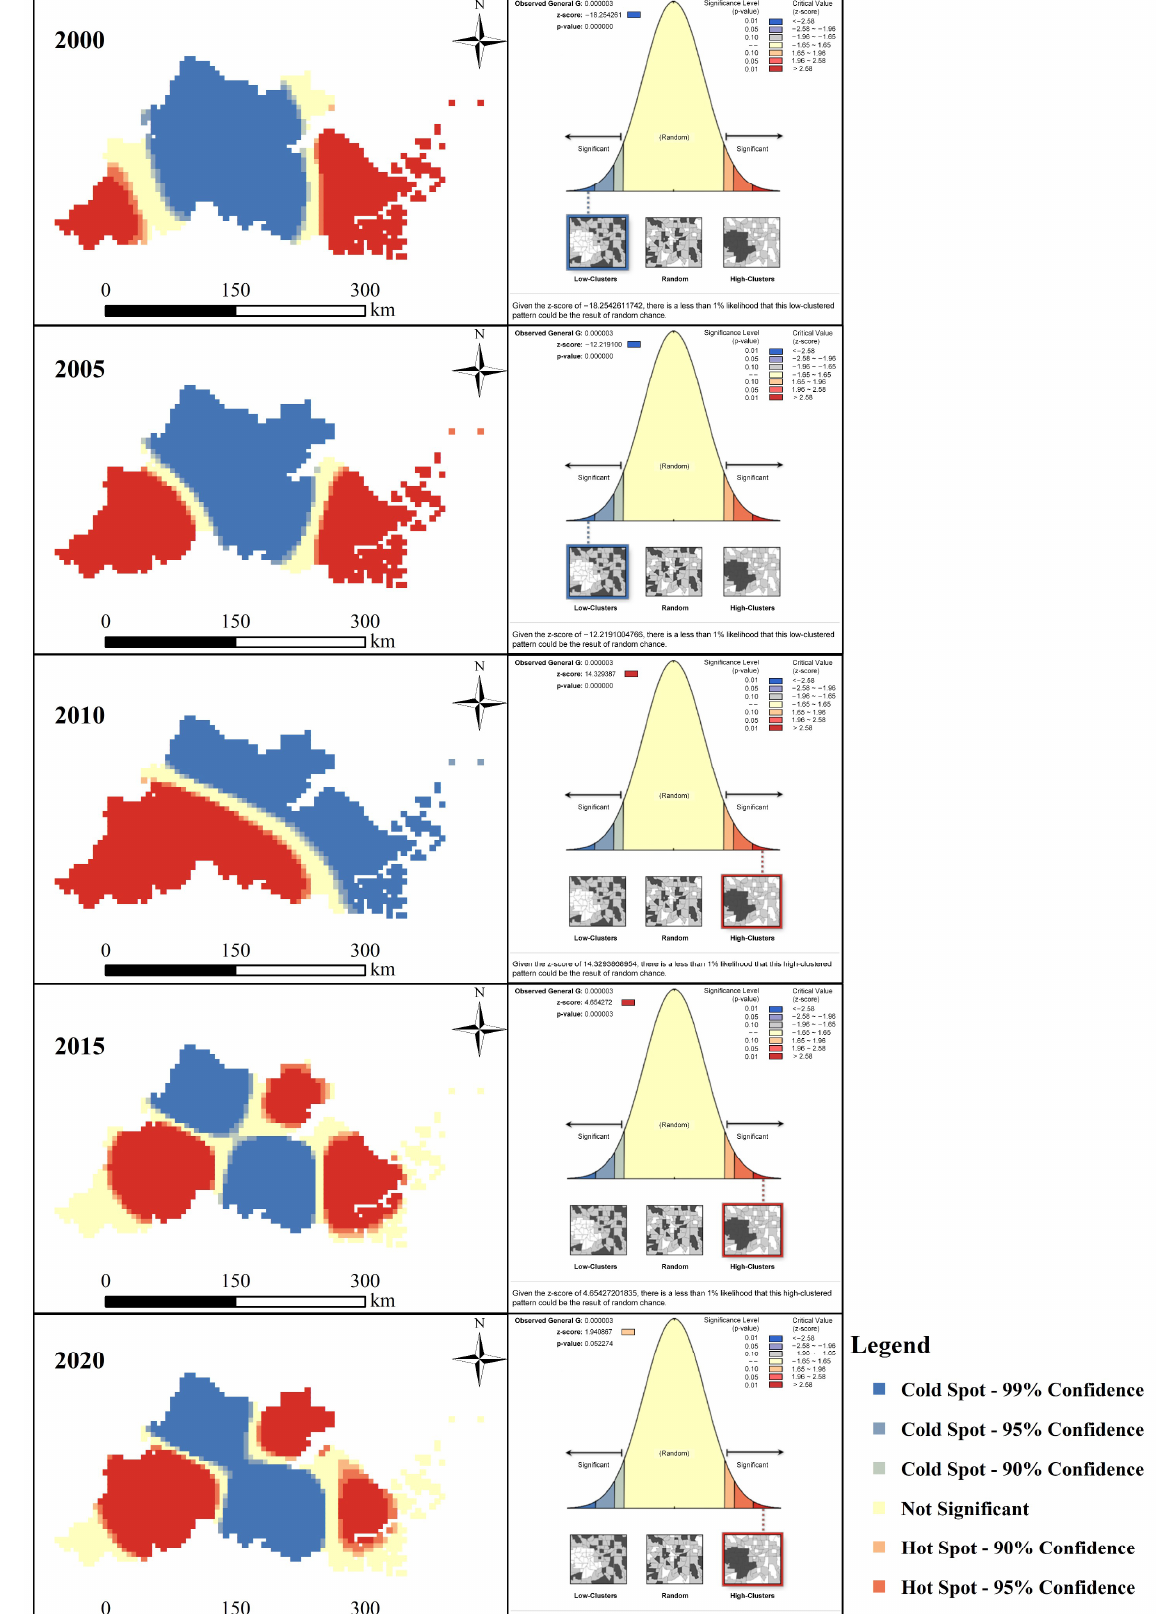
Figure 7. Spatial pattern characteristics of URID in HBUA from 2000 to